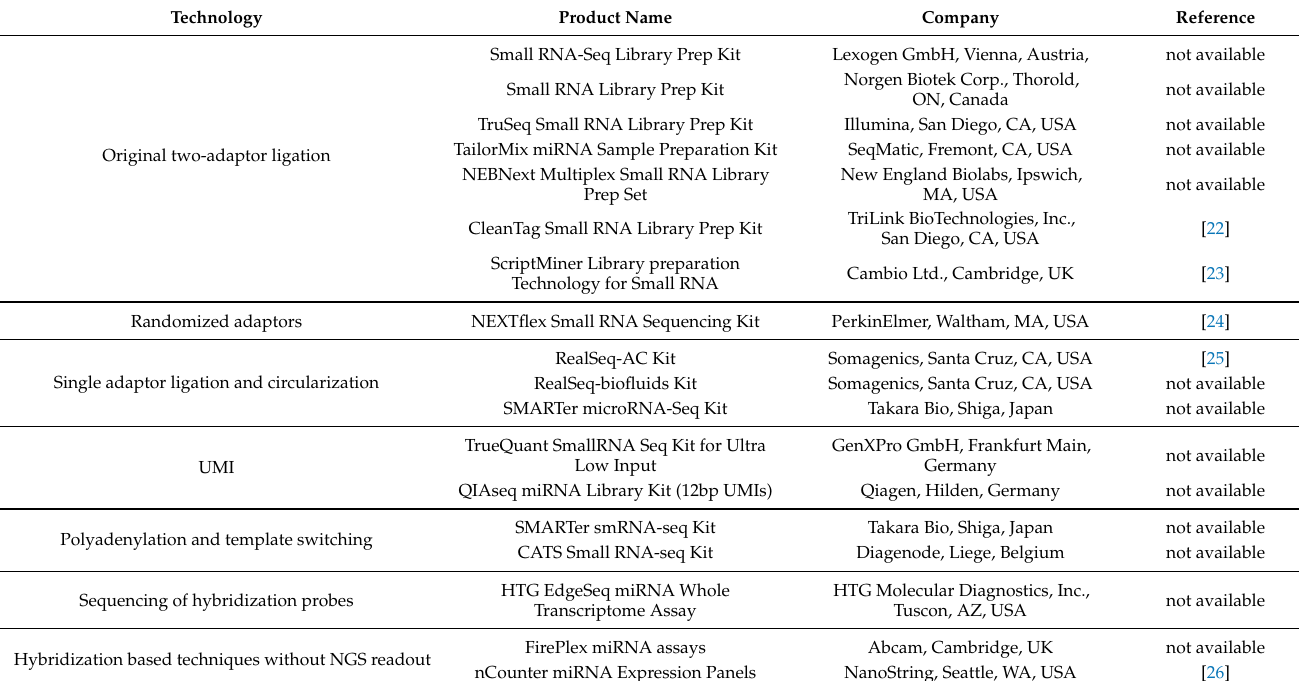
Table 1. Overview of commercially available protocols for small RNA-seq